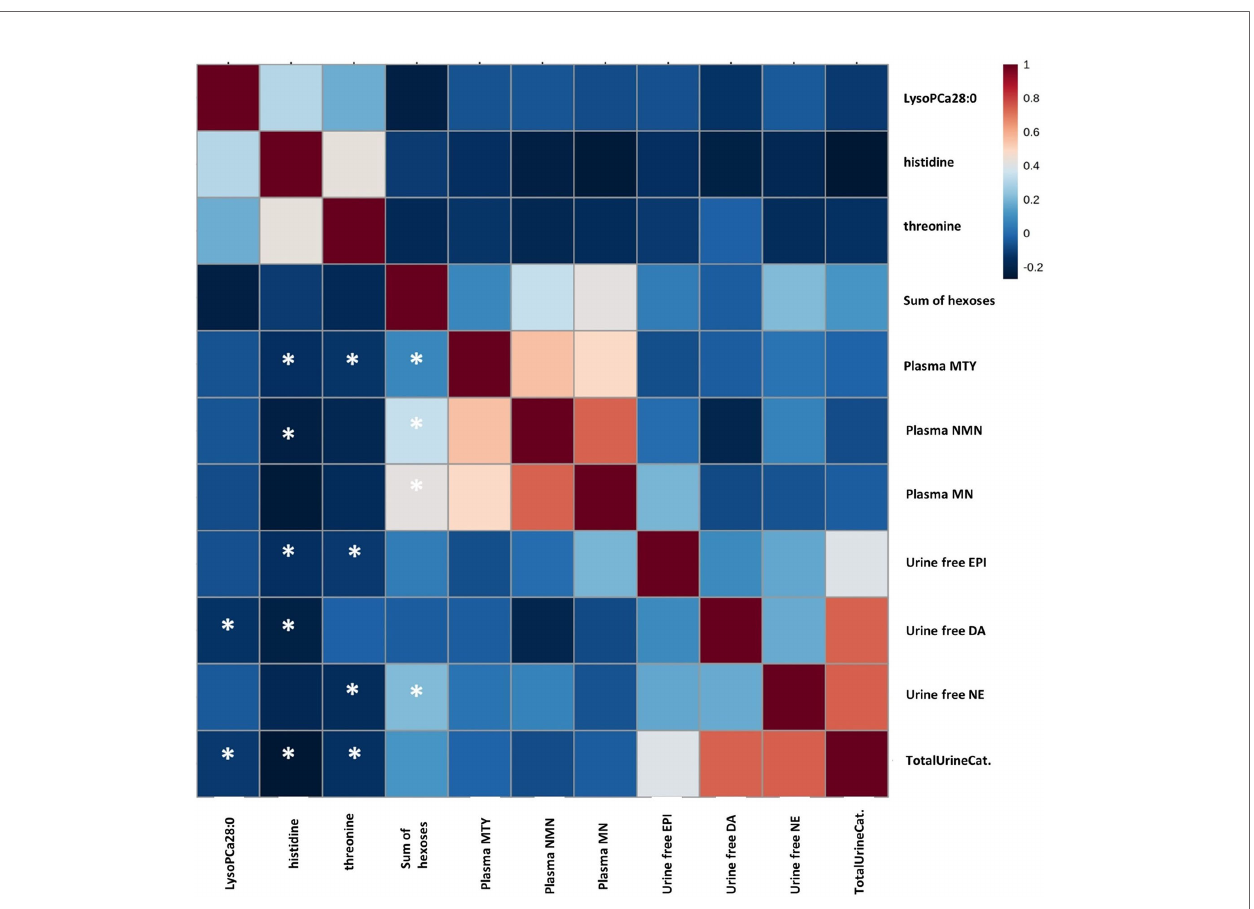
FIGURE 3 | Correlation between plasma concentrations of metanephrine, normetanephrine, and methoxytyramine, 24h urine concentrations of catecholamines, and plasma concentrations of signi fi cantly altered metabolites in PPGL patients. Spearmen-coef fi cient r s is presented by color coding (positive correlation: red; negative correlation: blue). An Asterisk indicates a statistically signi fi cant correlation at the level of (p < 0.05). DA, dopamine; EPI, epinephrine; MN, metanephrine; MTY, methoxytyramine; NE, norepinephrine; TotalUrineCat, Total urine